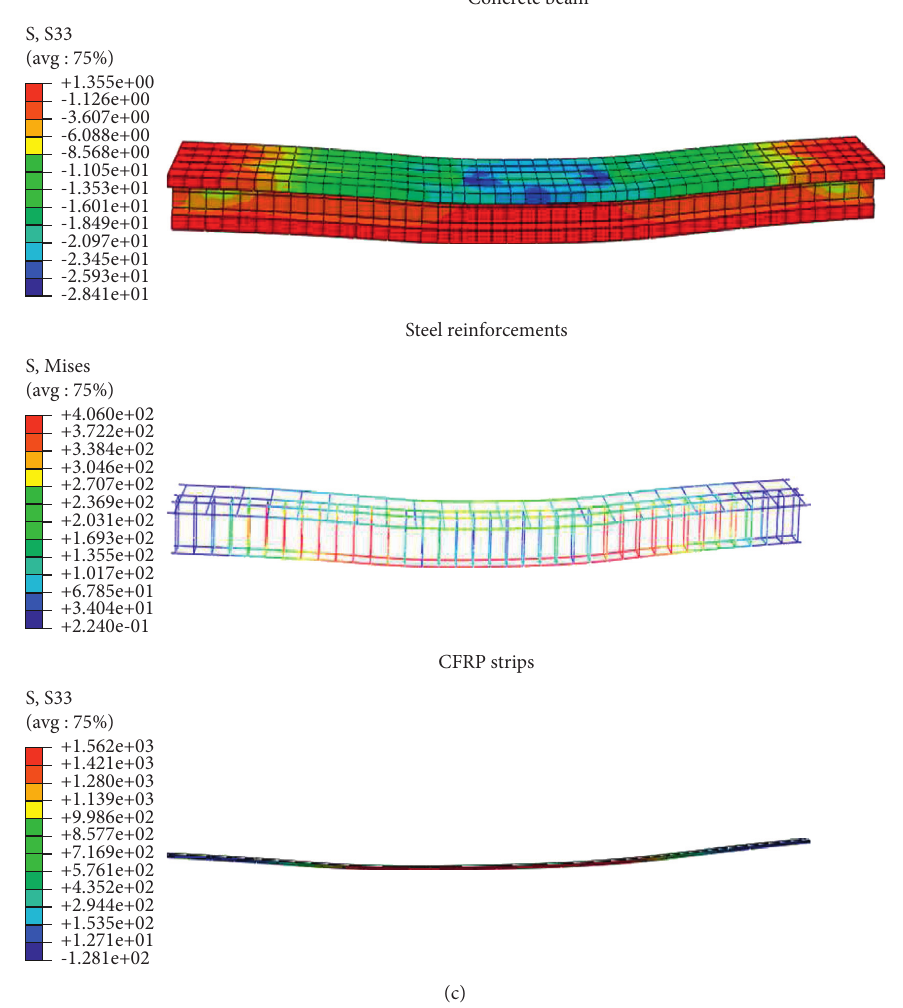
Figure 5: Longitudinal stress distribution along the beam length: (a) stress nephogram of point A, (b) stress nephogram of point B, and (c) stress nephogram of point